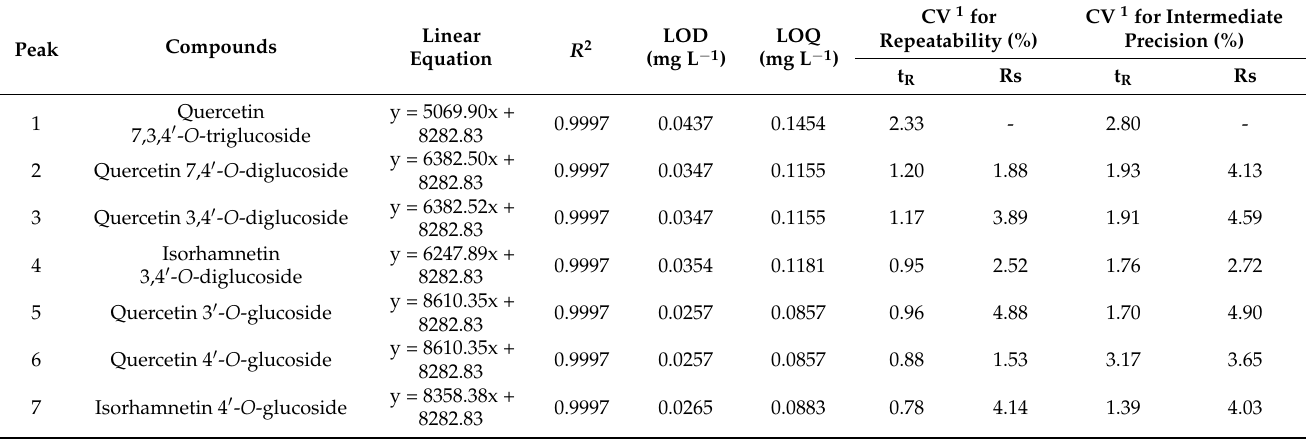
Table 3. Validation of the developed UHPLC method.